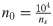
Survival area in the phase diagram α × D versus the number of sources ns for 0 < D < 1.The case D = 1 is excluded because it implies no reproduction/death. The case D = 0 is excluded because it implies no migration between the patches. In all cases we keep the initial subpopulation size fixed n0=104ns and we use N = 104
L.